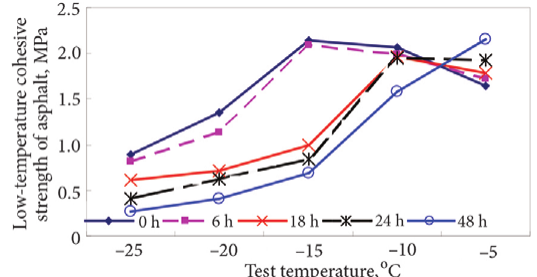
Figure 9. Influence of the ageing effects on the peak time of SBS-modified bitumen low-temperature cohesive strength